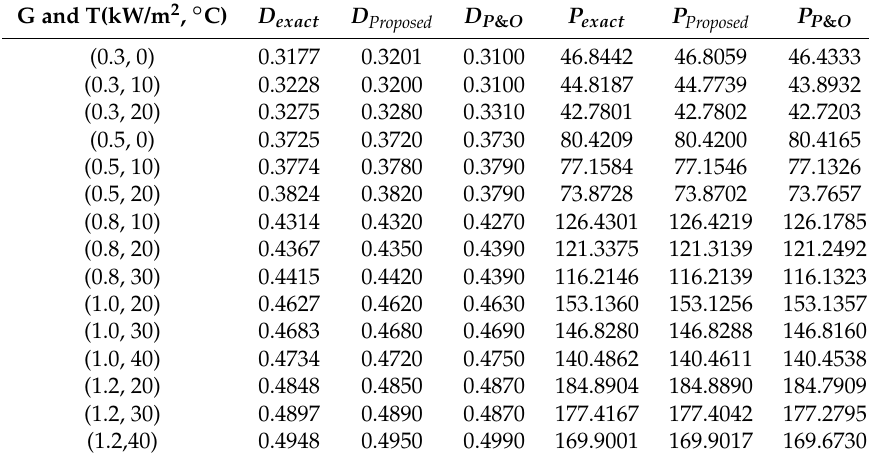
Figure 8. ( a ) Comparison of percentage of error in duty cycle under 25 ◦ C between Proposed and conventional Perturb and Observe (P&O) algorithm ( b ) Comparison of percentage of error in Maximum Power Point under 25 ◦ C between Proposed and conventional P&O algorithm. Table 4. Comparison of duty cycle and maximum power between Proposed and P&O algorithm at different irradiance and